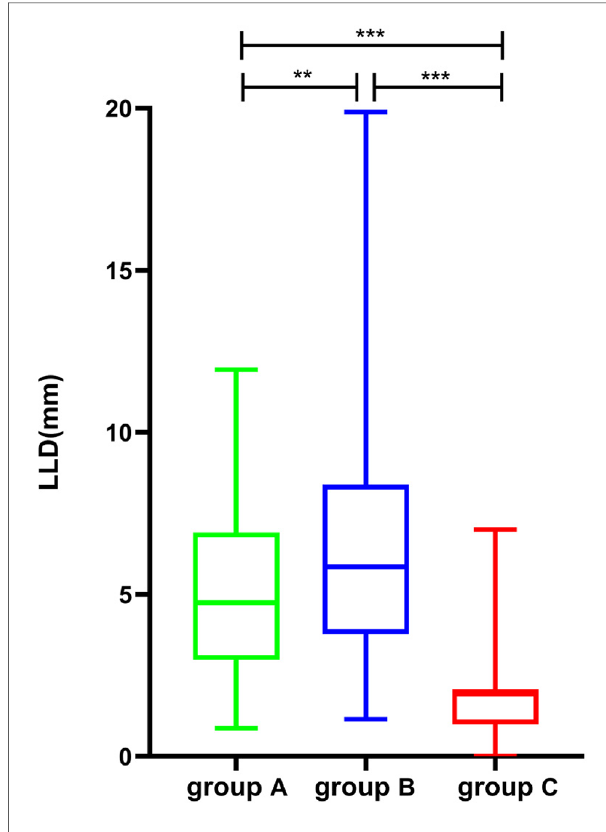
FIGURE 4 Comparison of postoperative LLD in patients of groups A, B, and C (** p